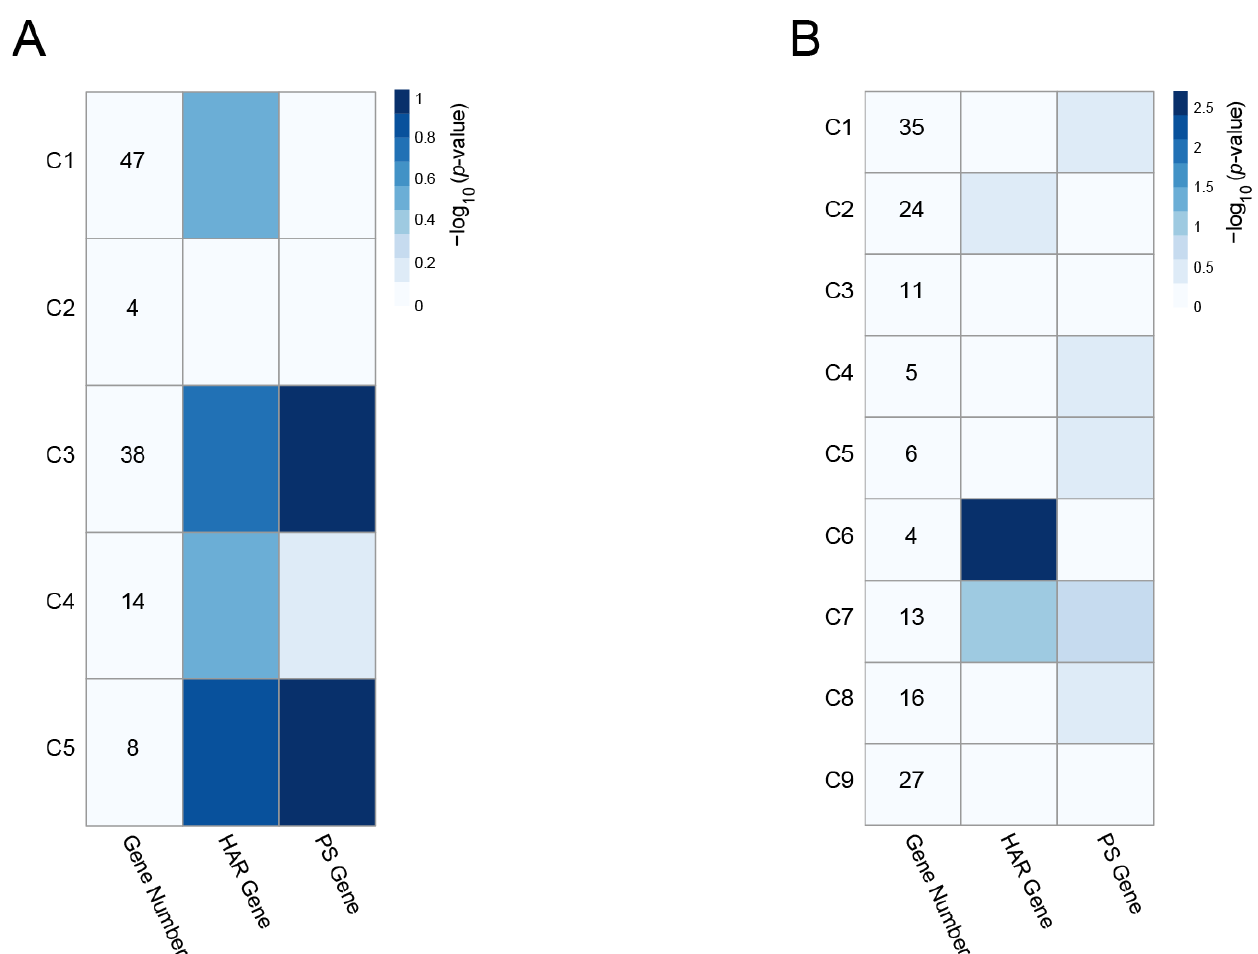
Figure 8. Densely connected clusters in the cyan ( A ) and magenta ( B ) module PPI network. With the use of the MCODE plugin, five significantly connected PPI clusters were extracted from the cyan module PPI network, and nine significantly connected PPI clusters were extracted from the magenta module PPI network. Cluster-level enrichment was assessed for two evolutionary gene sets: HAR genes and PS genes. In each cell, the shades of blue represent the − log 10 ( p -value) for the significance of the overlap, obtained by Fisher ’ s exact test.